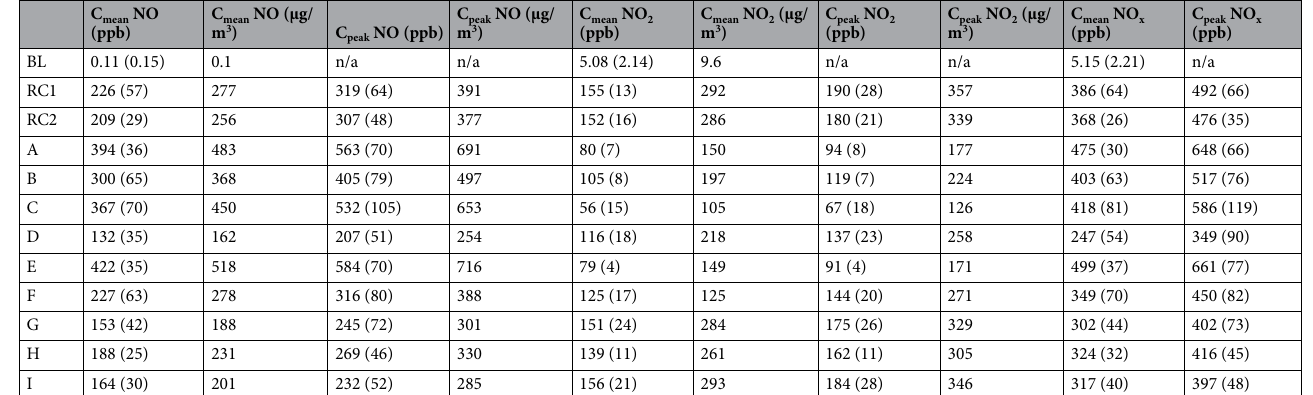
Table 2. Mean concentrations (C mean ) and peak concentrations (C peak ) of nitric oxide (NO), nitrogen dioxide (NO 2 ), and nitrogen oxides (NO x ) of the measured baseline (BL), reference cigarette 3R4F (RC1, RC2), and the cigarette brands A (Marlboro Gold UAE), B (Marlboro Gold GER), C (Winston Red UAE), D (Winston Classic GER), E (Parliament Platinum UAE), F (Parliament Night Blue GER), G (Pall Mall Menthol Blast), H (Winston Menthol), and I (Elixyr Menthol). UAE United Arab Emirates, GER Germany. The given concentrations in